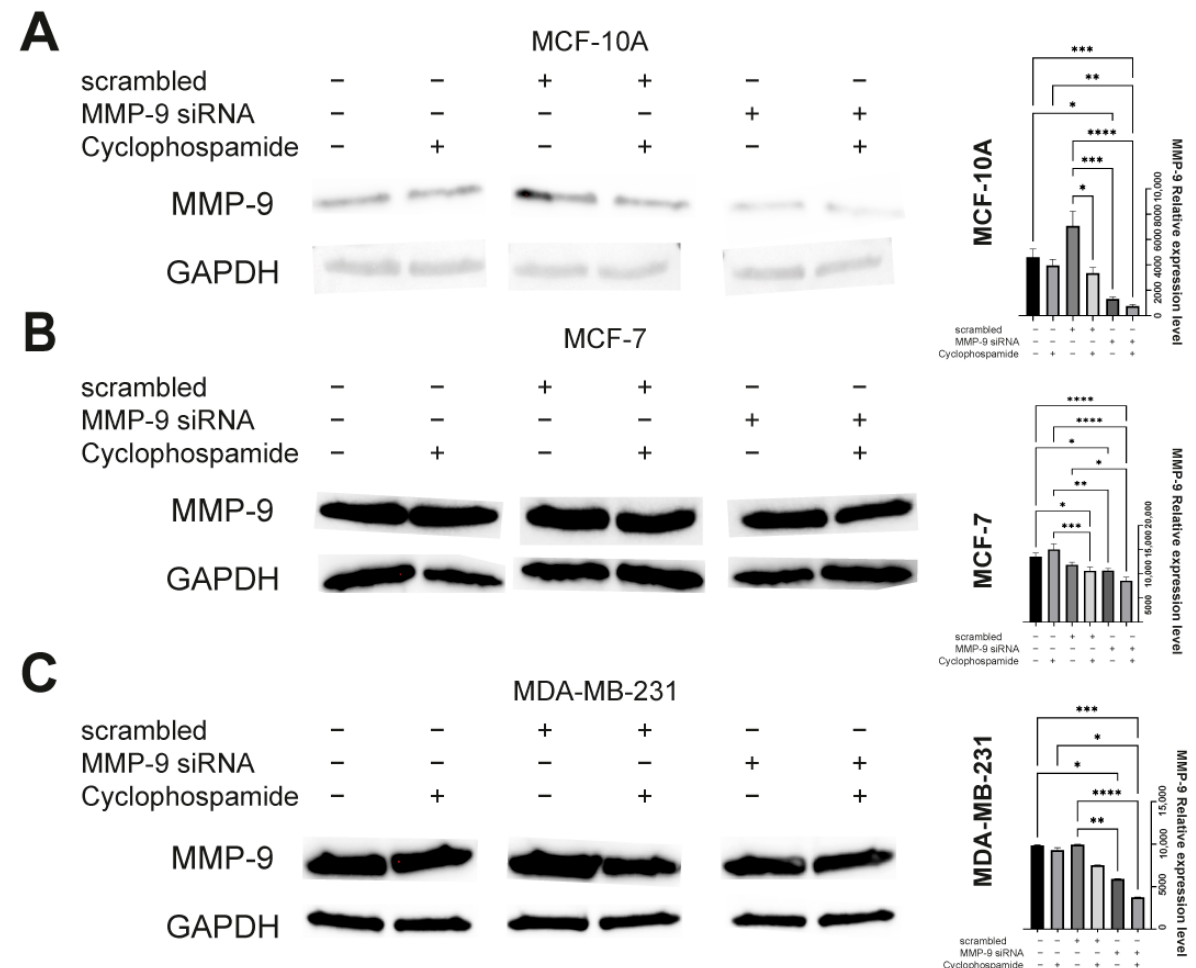
Figure 1. The Western blot verification of MMP-9 silencing. ( A ) MCF-10A, ( B ) MCF-7, and ( C ) MDA-MB-23 cells non- transfected, transfected with control siRNA (scrambled) and transfected with MMP-9 siRNA treated with cyclophosphamide at 5 mM concentration. Statistically significant differences were marked with ‘*’ p ≤ 0.05, ‘**’ p ≤ 0.01, ‘***’ p ≤ 0.001, and ‘****’ p ≤ 0.0001 (Kruskal-Wallis test).